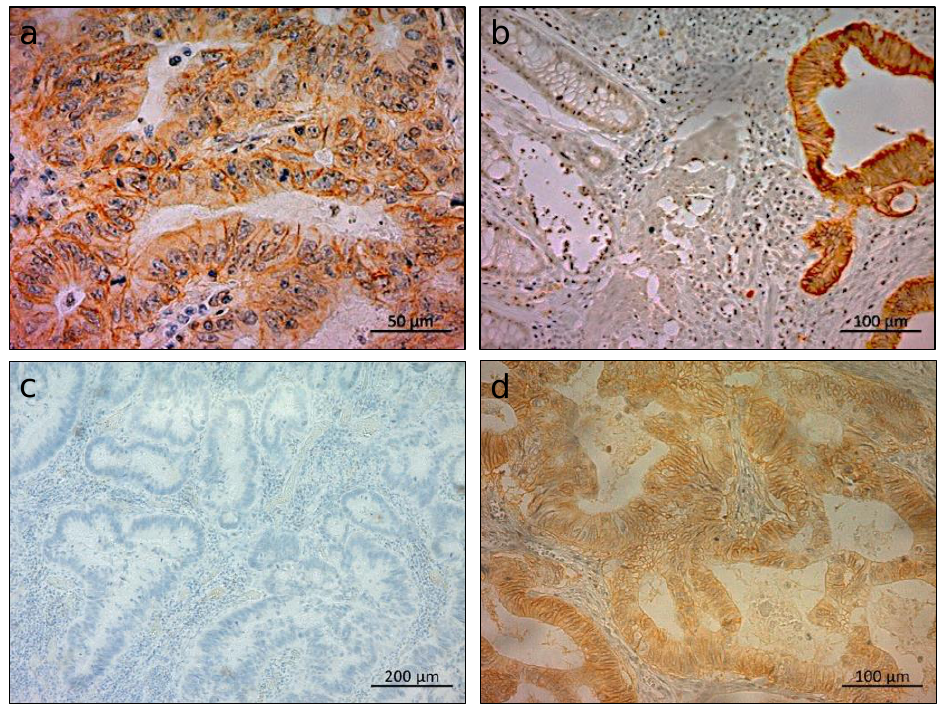
Figure 1. Immunohistochemical staining of LAT1 in clinical CRC samples. ( a ) Representative immunohistochemical staining of membrane LAT1 expression in cancerous areas of CRC tissues (scale bar, 50 µ m) ( b ) Representative immunohistochemical staining of membrane LAT1 in the cancer part and non-cancerous colon mucosa (scale bar, 100 μm). Stronger LAT1 expression was observed in cancer tissues compared to normal colon mucosa. ( c ) Representative section of a CRC tissue with LAT1-negative expression. ( d ) Representative section of a CRC tissue with LAT1 positive expression. Table 1. Relationship between LAT1 positivity and various clinicopathological